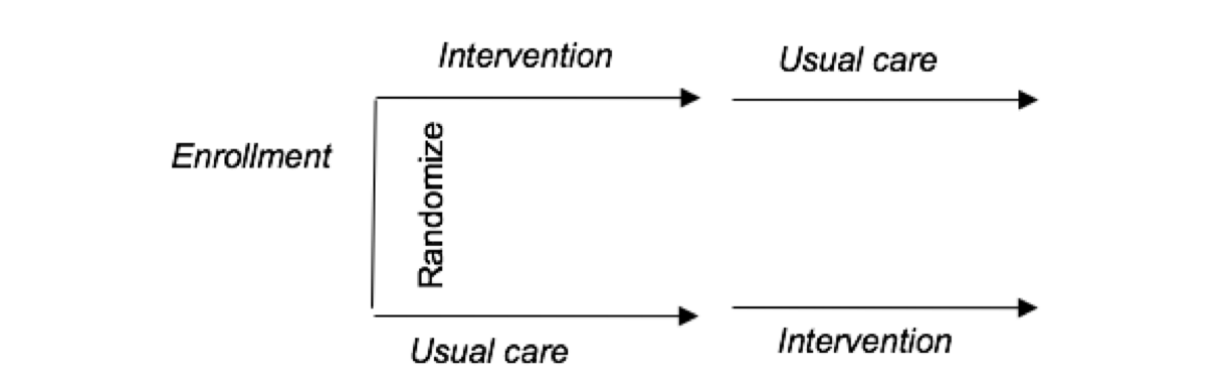
Figure 1. Randomized crossover study